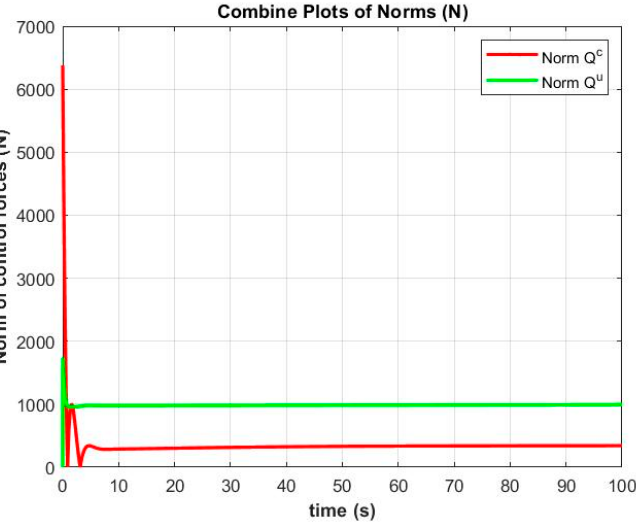
Figure 14. The comparison between the norms of the nominal control force and the additional control force.